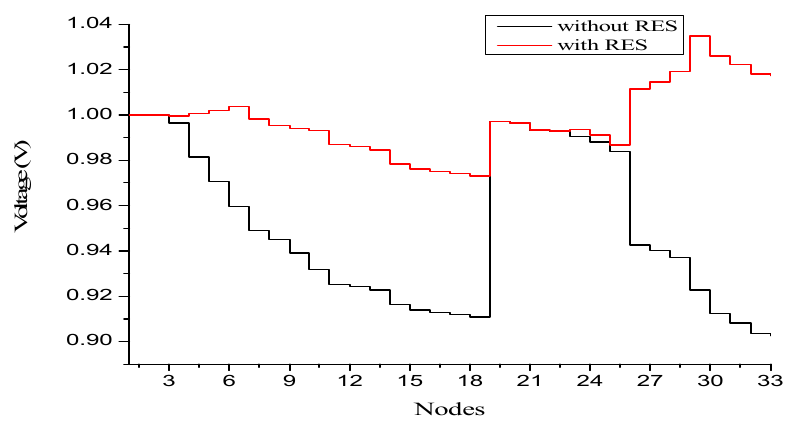
Figure 5. Reactive power losses with and without the integration of RES.